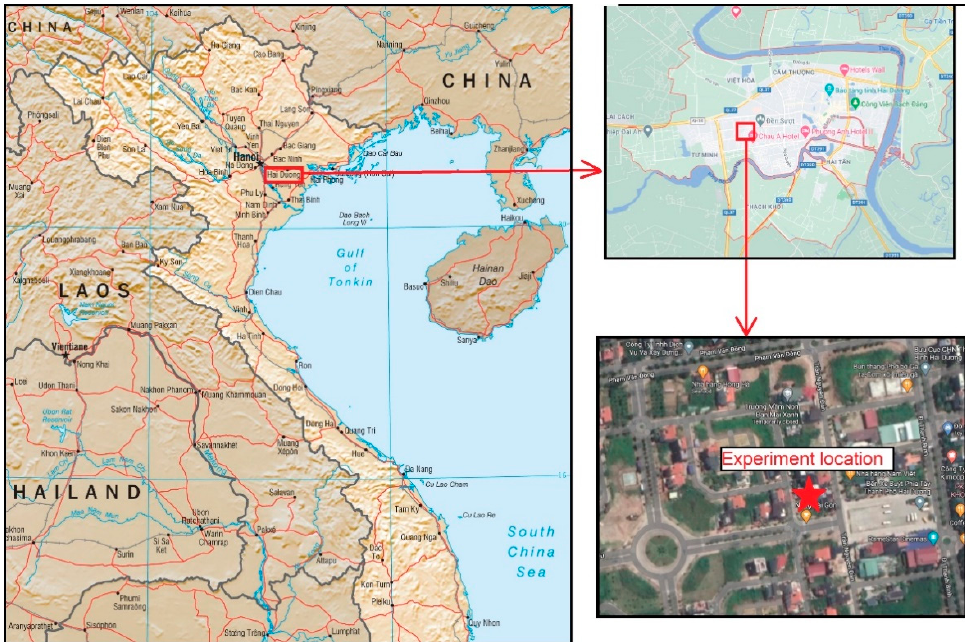
Figure 1. Experiment location.